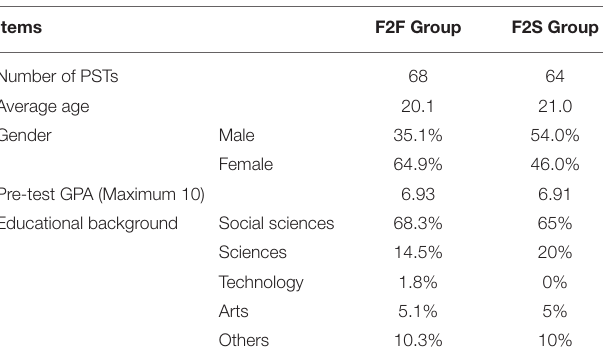
TABLE 1 | The comparison of demographic background information between PSTs participating in the F2F and F2S flipped classroom